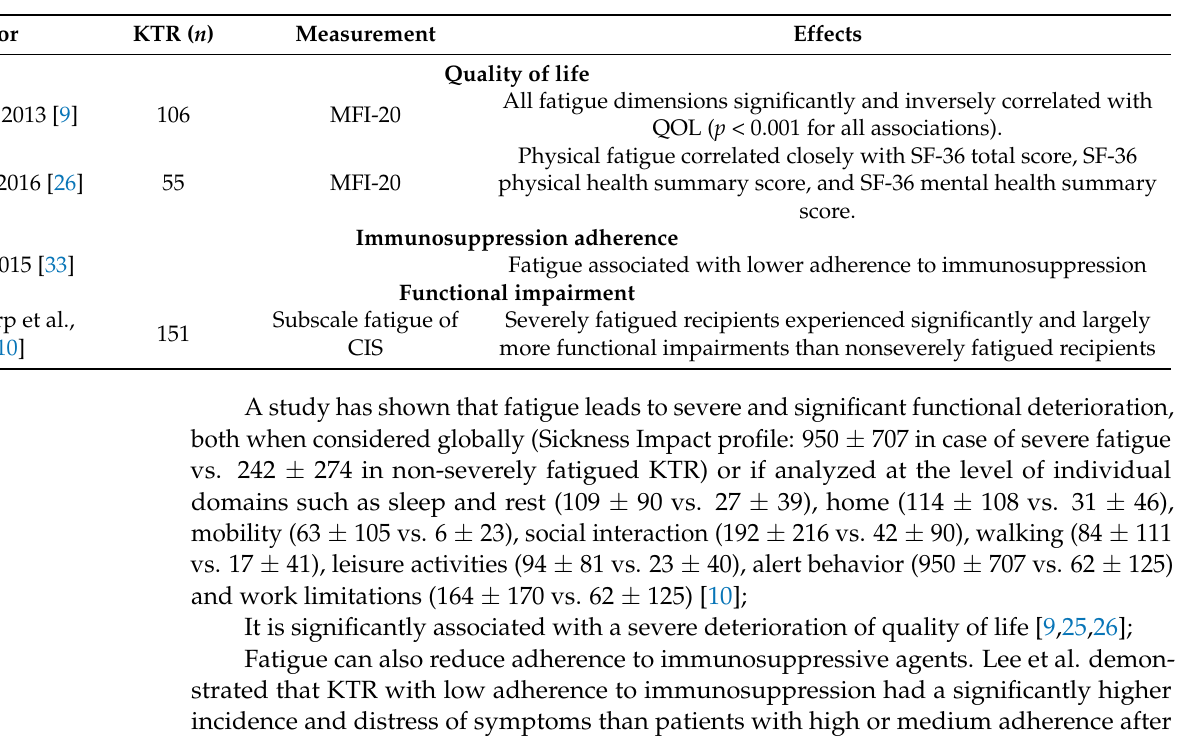
Table 3. Effects of fatigue in KTRs. MFI-20, Multidimensional Fatigue Inventory-20; CIS, Checklist Individual